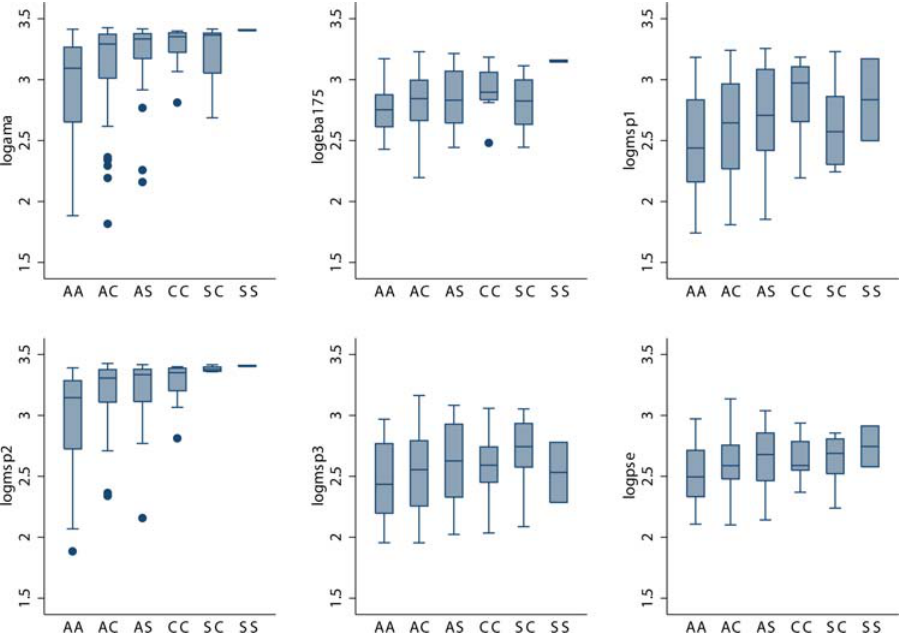
Figure 2. Means levels of total IgG against several blood stage antigens of Plasmodiumfalciparum(AMA1, EBA-175, MSP-1 19 , MSP-2, MSP-3) and parasite schizont extract in urban samples of Mossi from Ouagadougou, Burkina Faso according to the different haemoglobin genotypes. The horizontal lines in each box correspond to the median values, the lower edge of each box is the 25% ile and the upper edge is the 75% ile. The whiskers represent the range of the data beyond these percentiles, excluding outliers represented by dots.